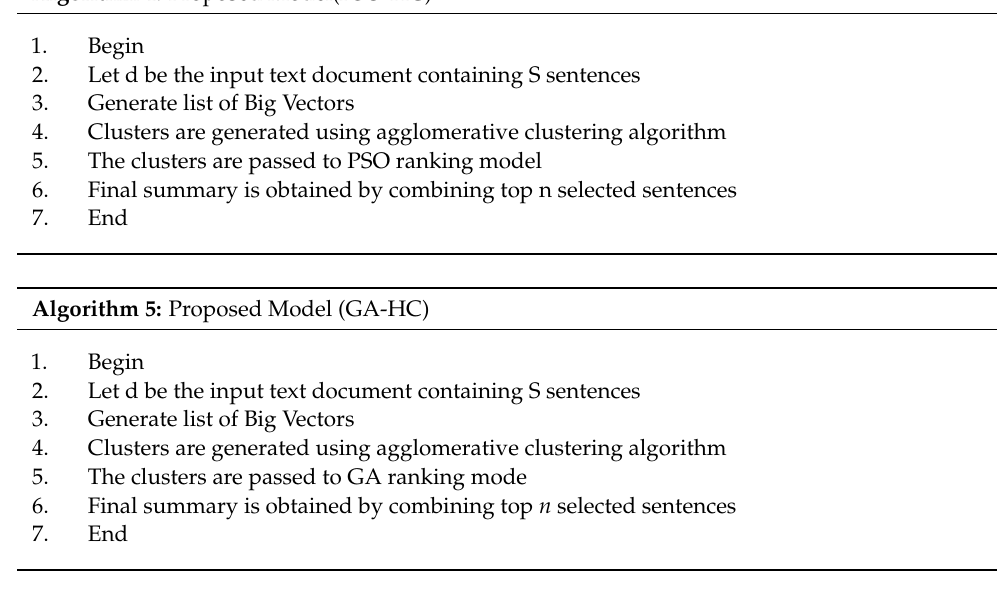
Algorithm 4: Proposed Model(PSO-HC)